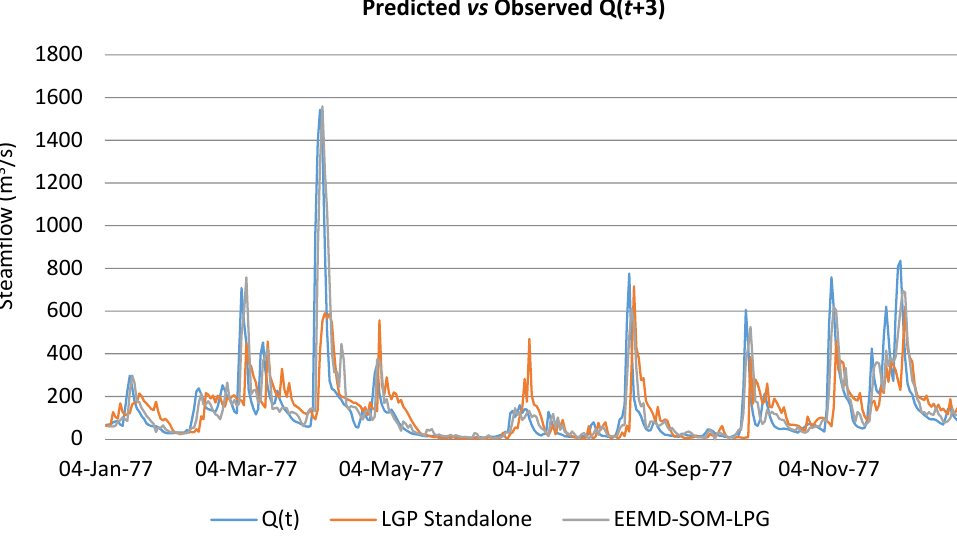
Figure 9. Scatter plots of observed vs. predicted for models in LGP-10. ( a ) Streamflow at 1 day ahead; Figure 8. Q( t +3) predicted vs observed for LGP-10 and LGP as a standalone. ( b ) streamflow at 2 days ahead; ( c ) streamflow at 3 days ahead; ( d ) streamflow at 4 days ahead.